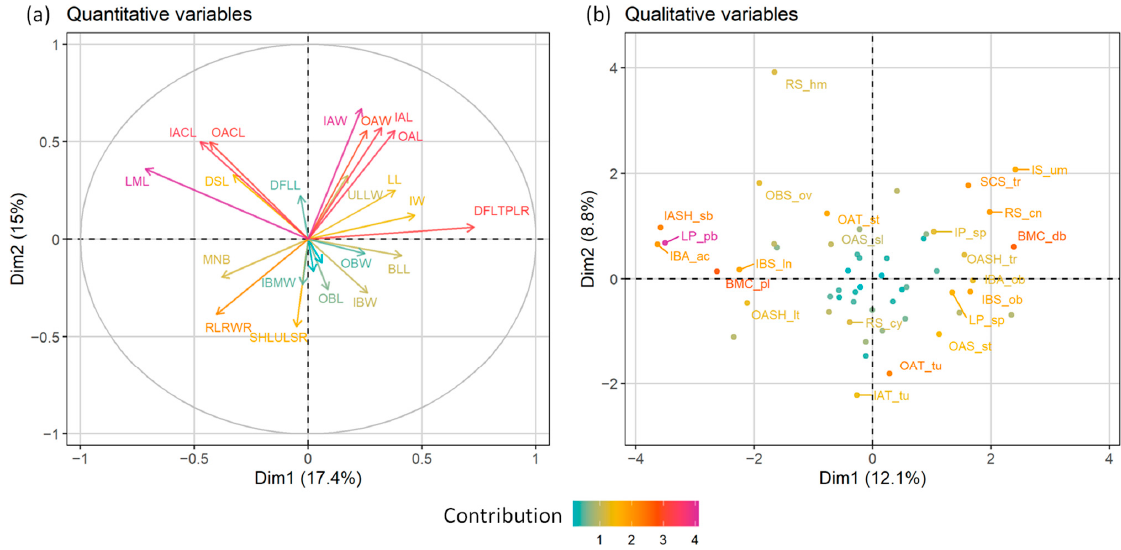
Figure 6. Relative contribution of the quantitative ( a ) and qualitative ( b ) morphological characters to the FAMD of Figure 5.